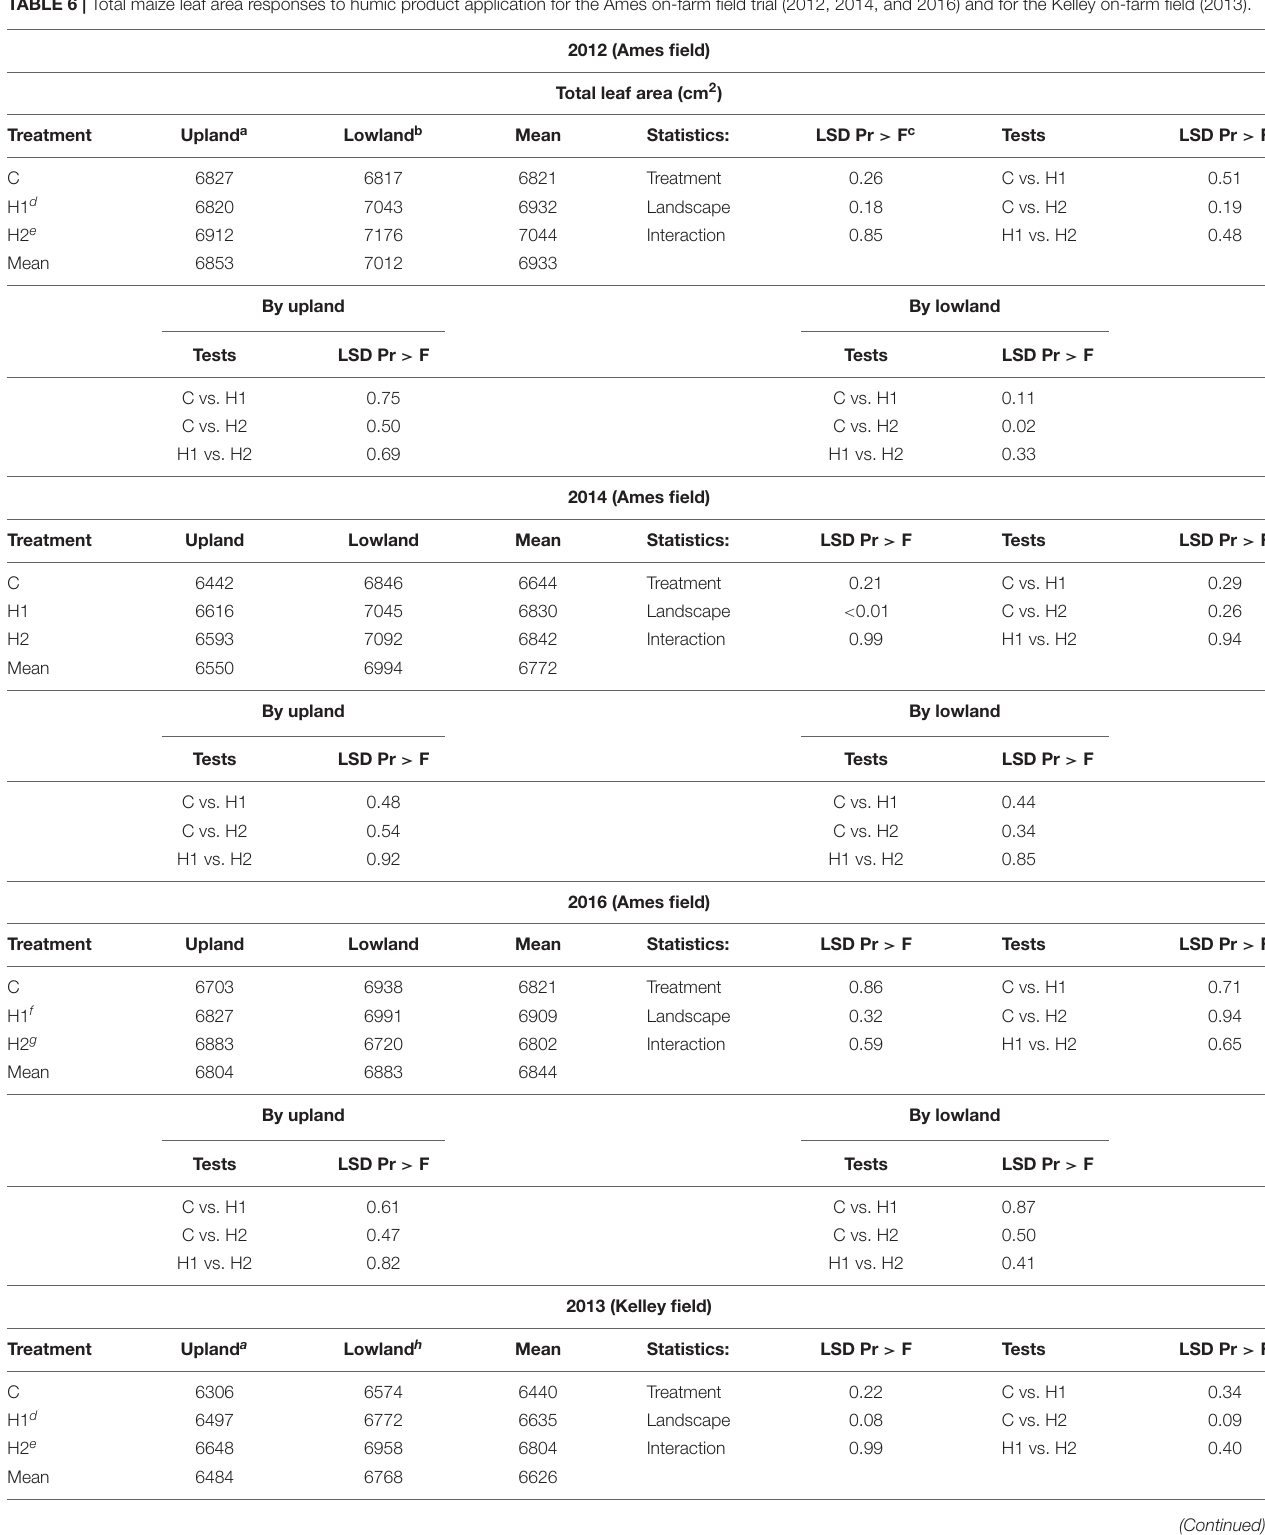
TABLE 6 | Total maize leaf area responses to humic product application for the Ames on-farm field trial (2012, 2014, and 2016) and for the Kelley on-farm field